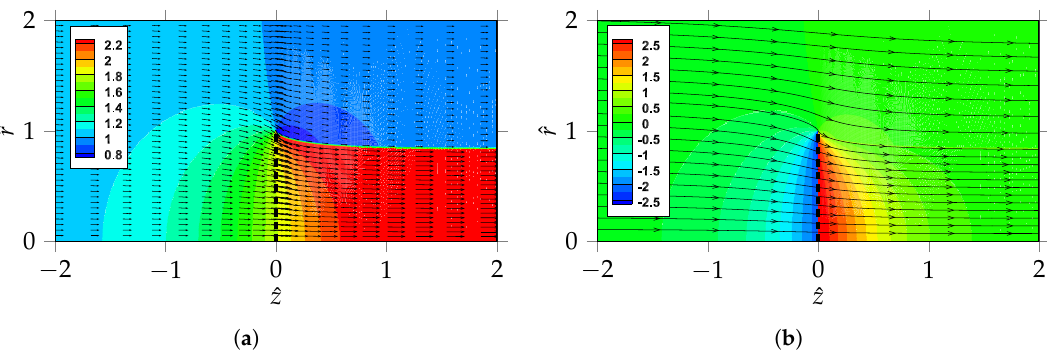
Figure 7. Flow field obtained through the FWRV-AD method for C T = 5. ( a ): vector field and contours of the velocity magnitude. ( b ): streamlines and contours of the pressure